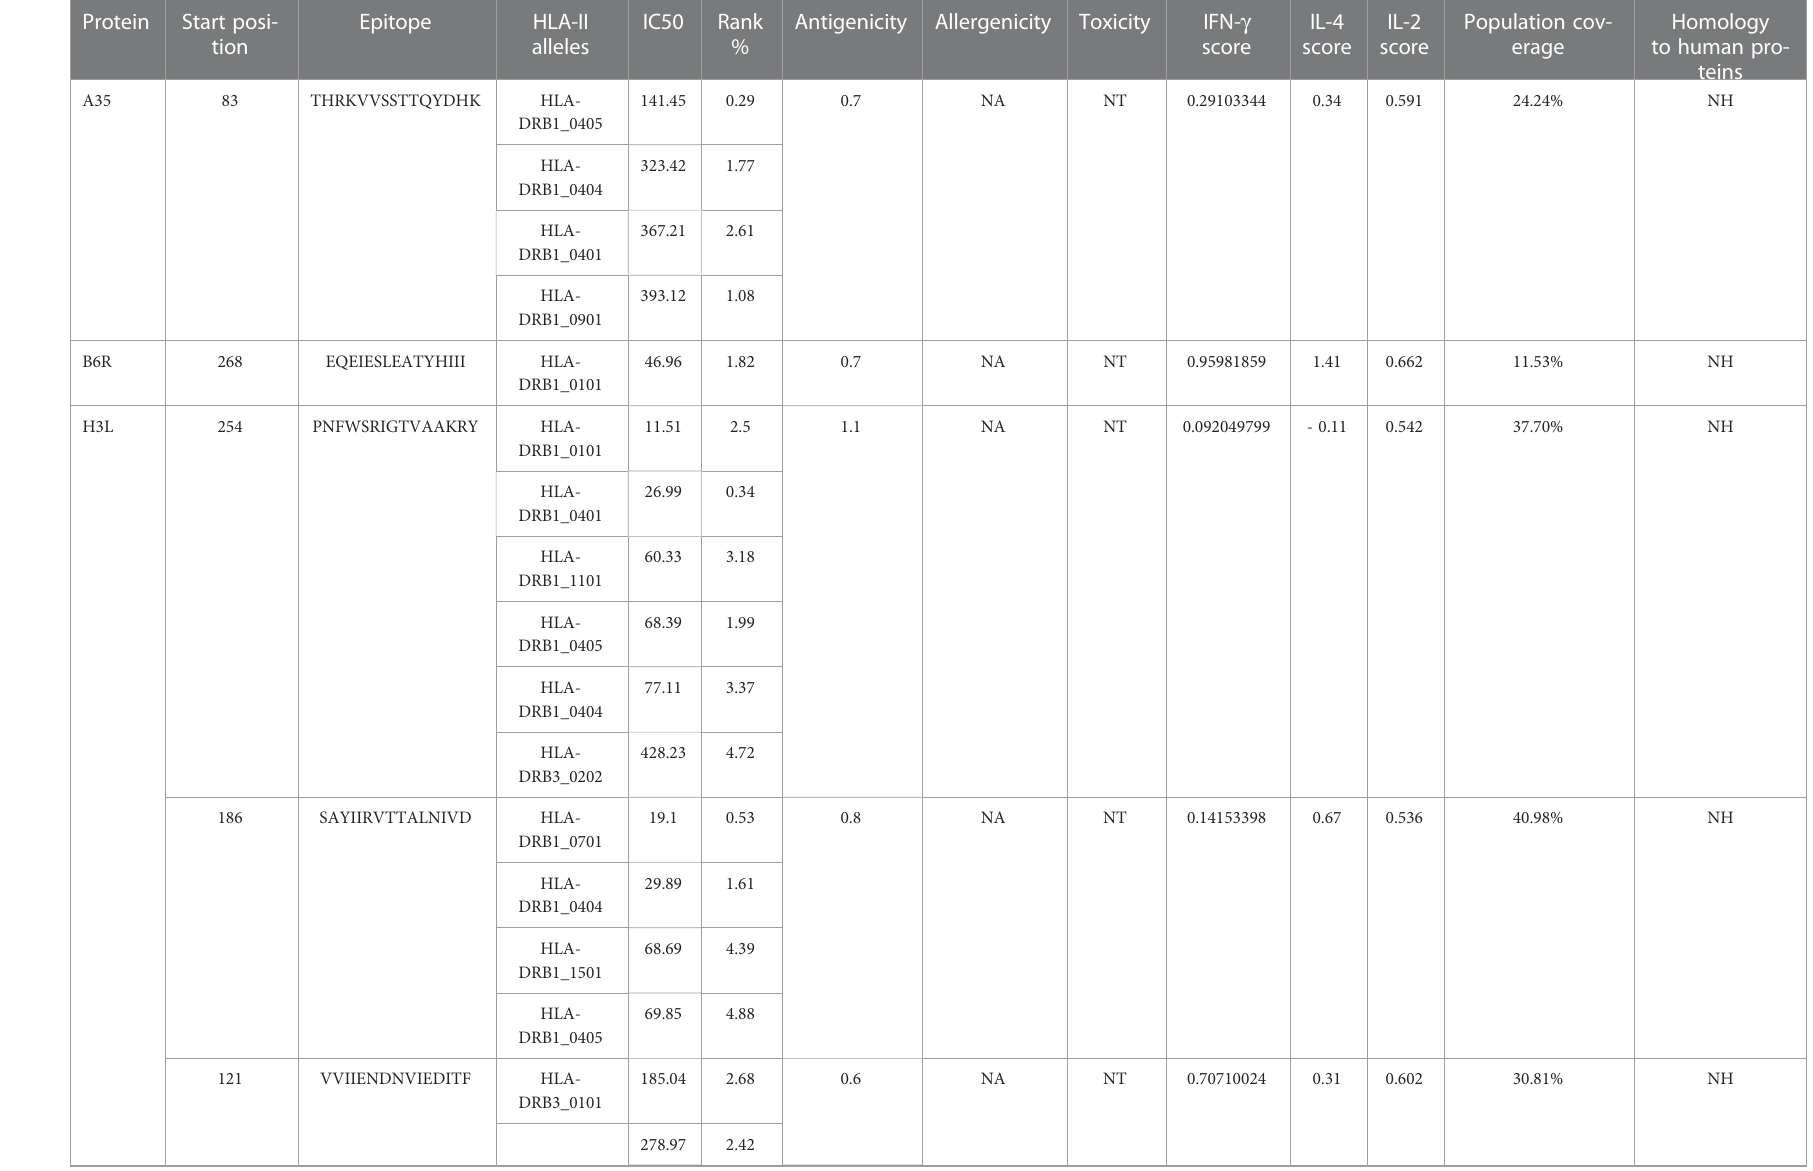
TABLE 2 List of the HTL epitopes selected for vaccine construction. Protein Start